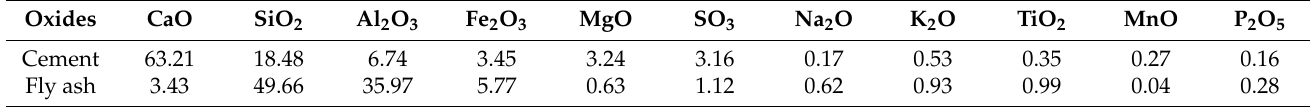
Table 2. Chemical compositions of the cement and the fly ash (wt.